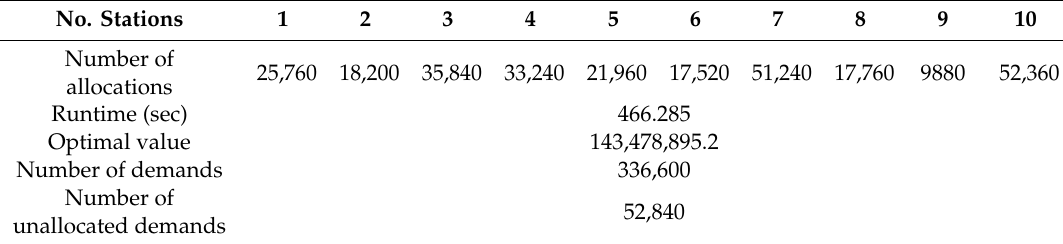
Figure 5. The allocation of each station using the Simulated Annealing algorithm. Table 2. The number of allocations for each station, runtime, and the optimal value of the function using the Simulated Annealing